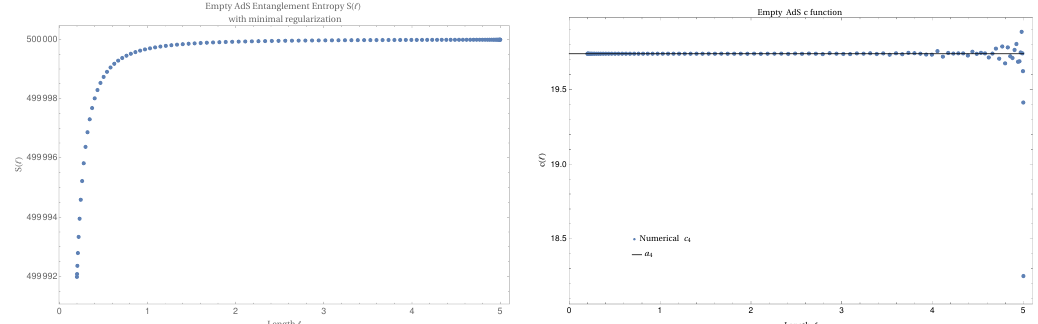
Figure 10 . The entanglement entropy and the c-function of N = 4 SYM theory as calculated in a vacuum state dual to empty AdS 5 spacetime. Left: the empty AdS 5 entanglement entropy. The values are regulated via minimal subtraction of the 1 /z 2 divergence. Right: the c-function, UV defined as c 4 = β 4 ‘ 3 ∂S/∂‘ by eq. (2.9). There is a loss of numerical precision beginning around ‘ ≈ 3 . 5 . The value that the c-function takes is approximately c 4 ≈ 2 π 2 in agreement with the value of the central charge of N = 4 SYM, a 4 = 2 π 2